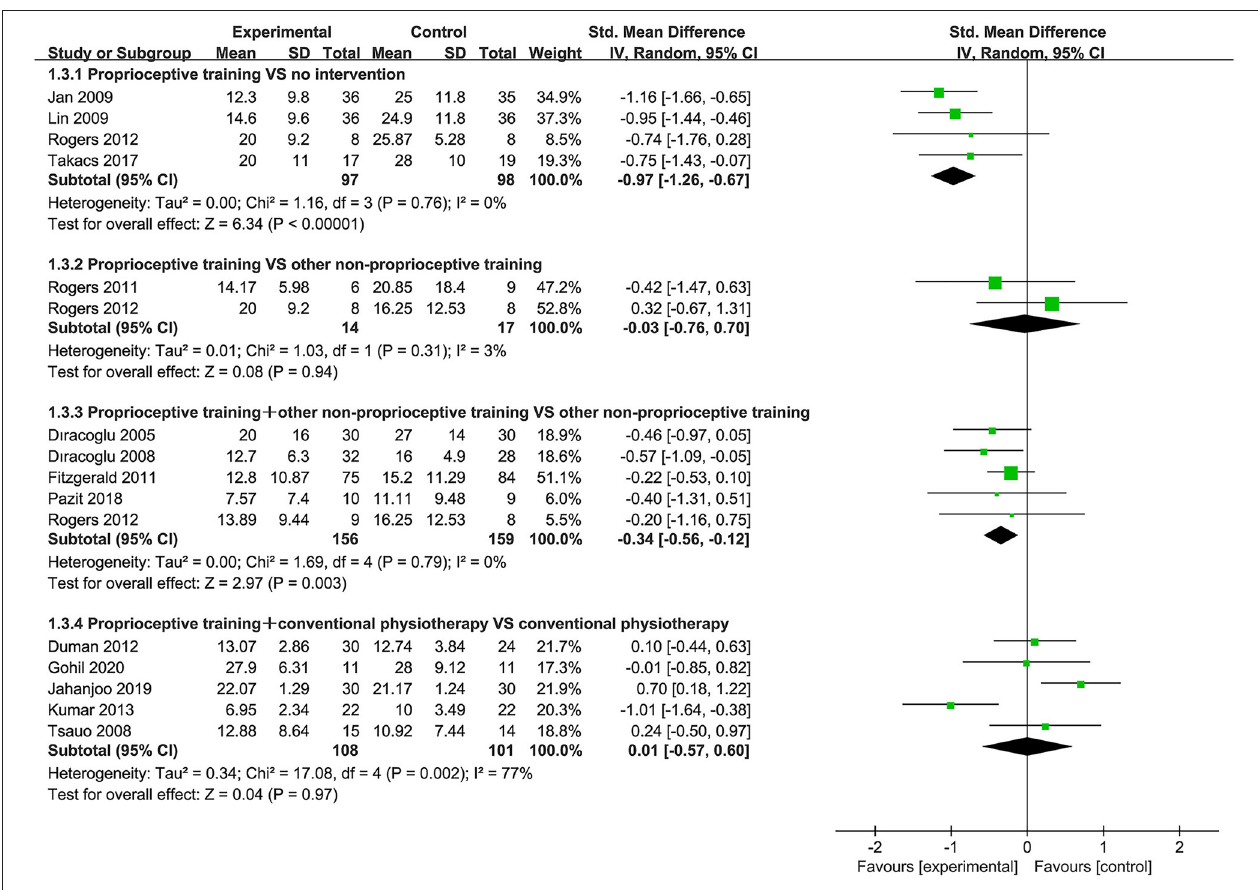
FIGURE 4 | Forest plot of meta-analysis on WOMAC (physical function)